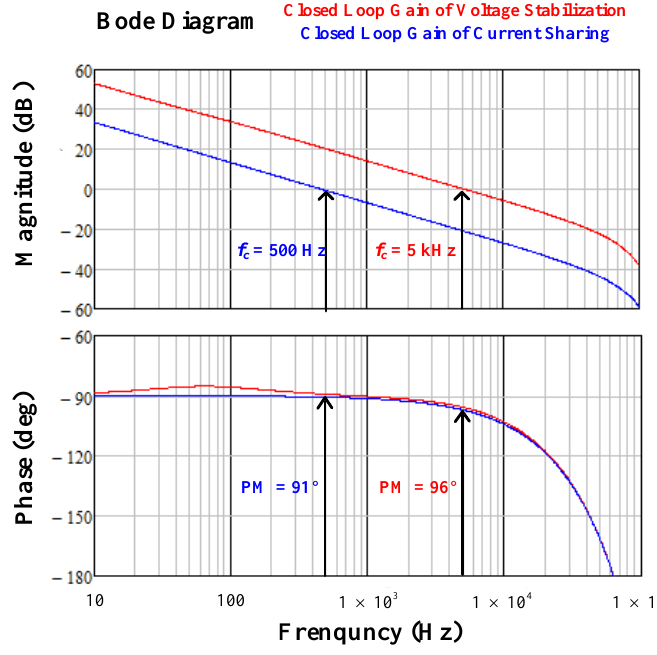
Figure 12. Bode plots of the compensated loop gain for both functions.